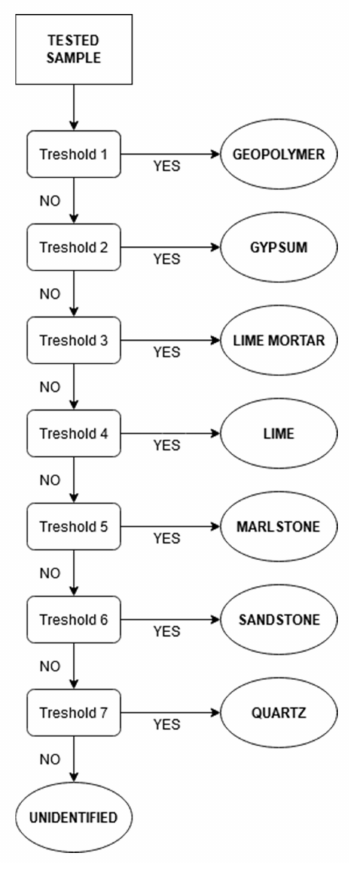
Figure 27. Decision tree